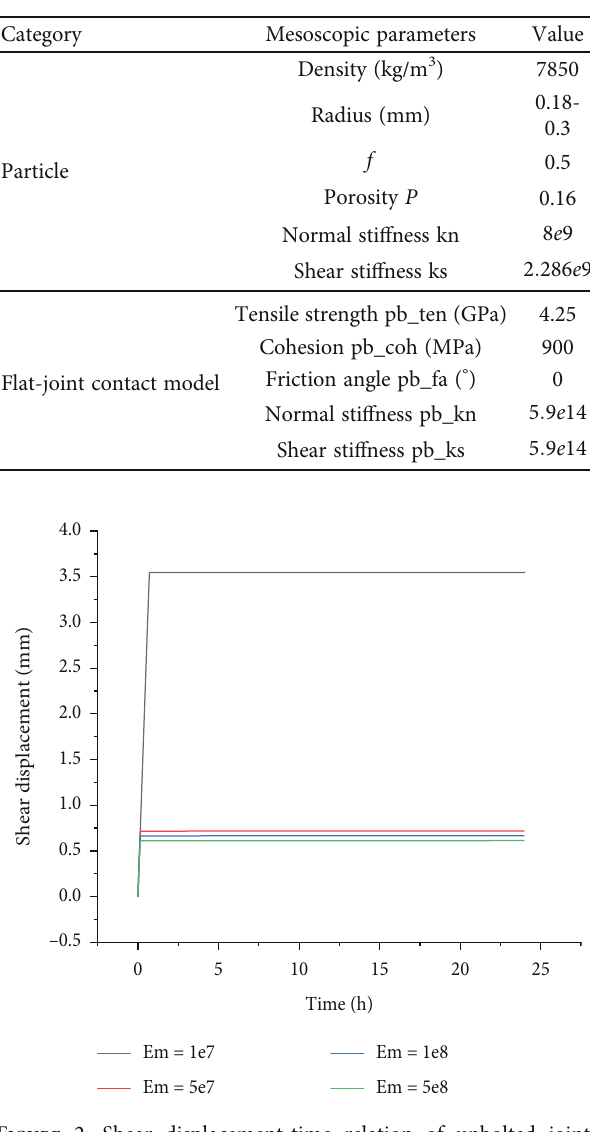
Table 2: Mesoscopic parameters of bolt.